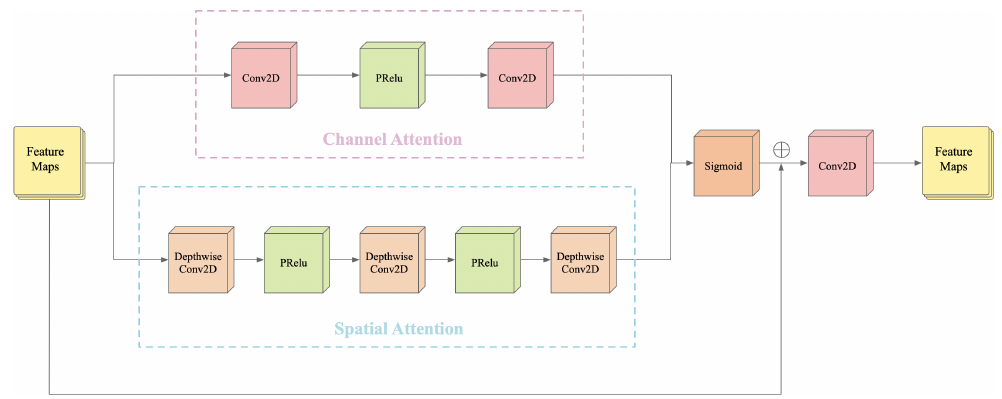
Figure 3. Hybrid attention module of